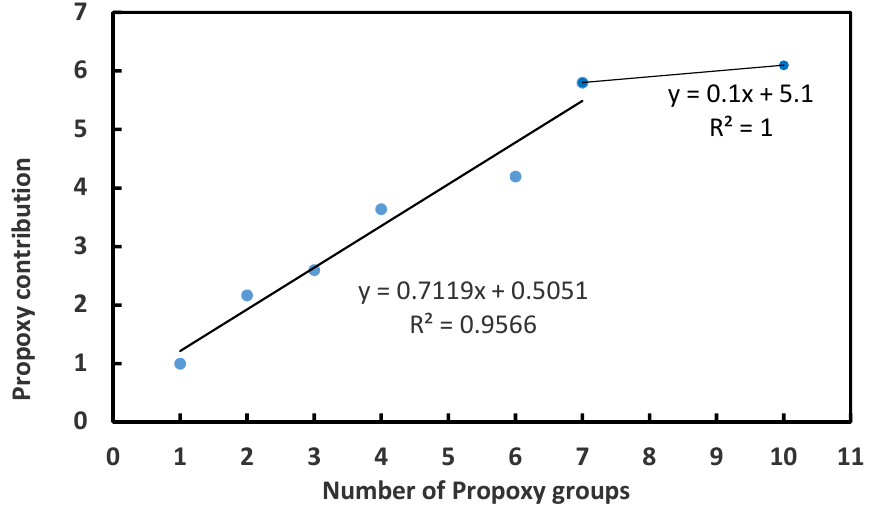
Figure 6. Propoxy contribution ξ versus number of Propoxy (C 3 H 6 O) groups in the molecule.